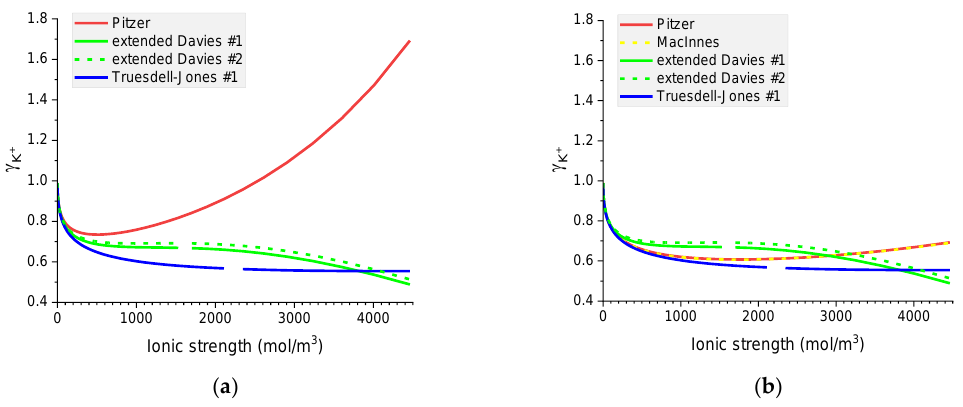
Figure 8. Molar K + individual activity coefficients in aqueous ( a ) KOH and ( b ) KCl solutions. Comparison of calculated activity coefficients based on the Pitzer, MacInnes, extended Davies, and Truesdell – Jones models at 25 °C.